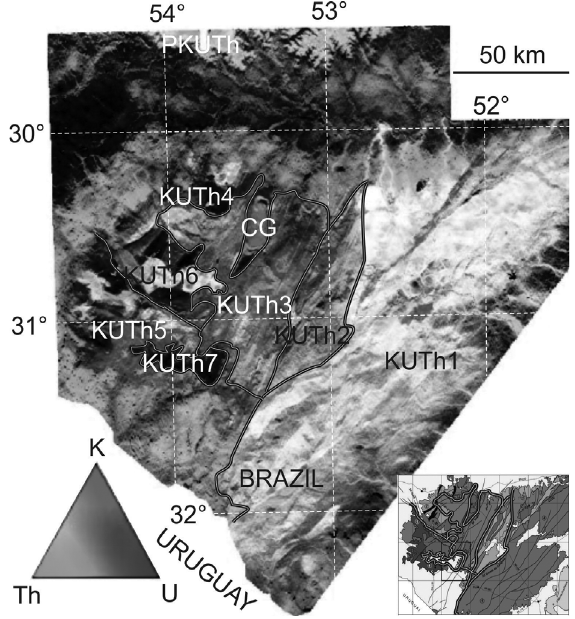
Figure 3 - Map of Th/K signal in the study area, indicating in red areas mostly the presence of clay minerals that retain Th. CG = Caçapava granite, CB = Camaquã Basin. For interpretation of the references to color in this fi gure legend, the reader is referred to the web version of this article.